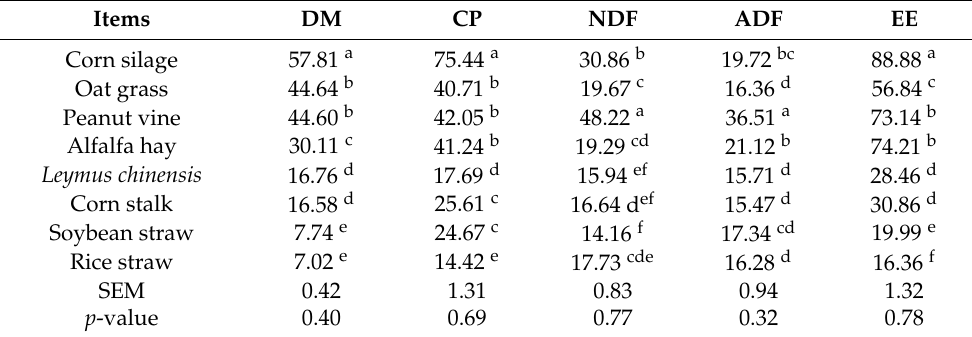
Table 6. Rumen digestibility of roughage nutrients 24 h (whole day) (%, dry matter).